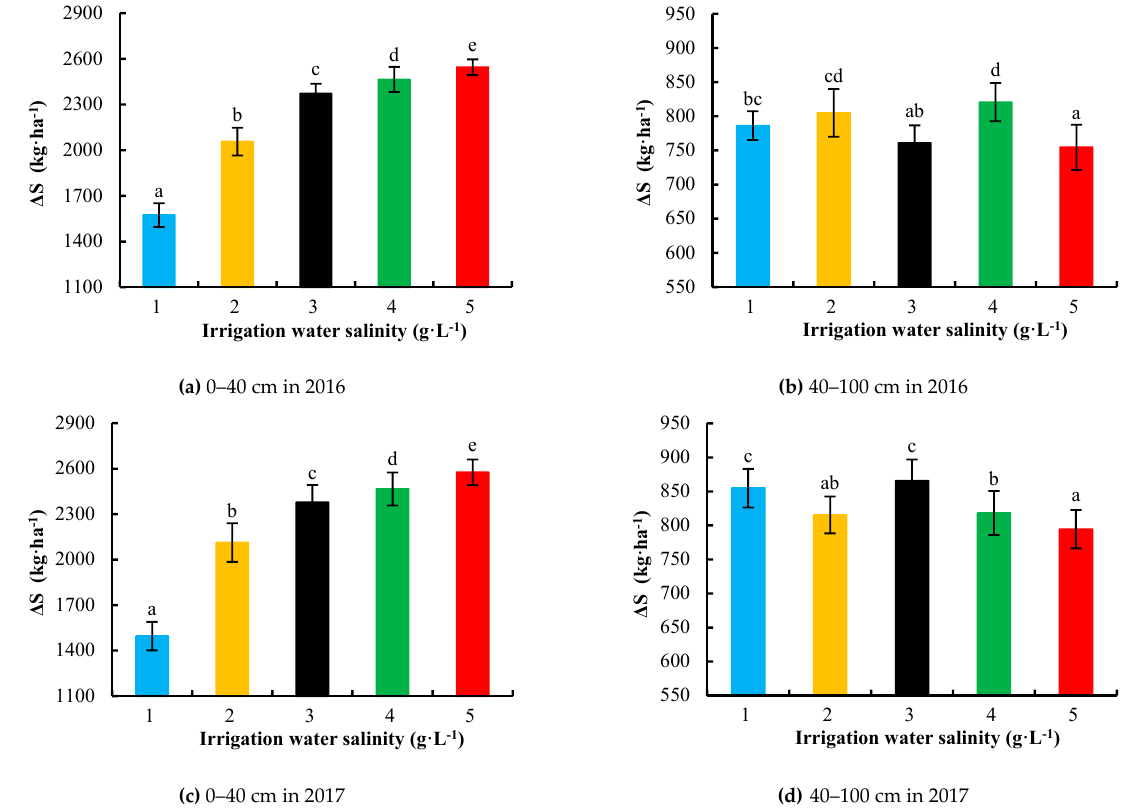
Figure 10. Variation of soil salinity during the growing period of maize for different treatments outside the film. Note: The same letter above the error bars represents no significantly different at p ≤ 0.05.